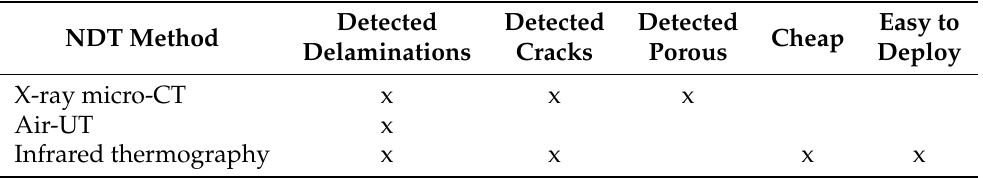
Table 1. Main differences among tested NDT